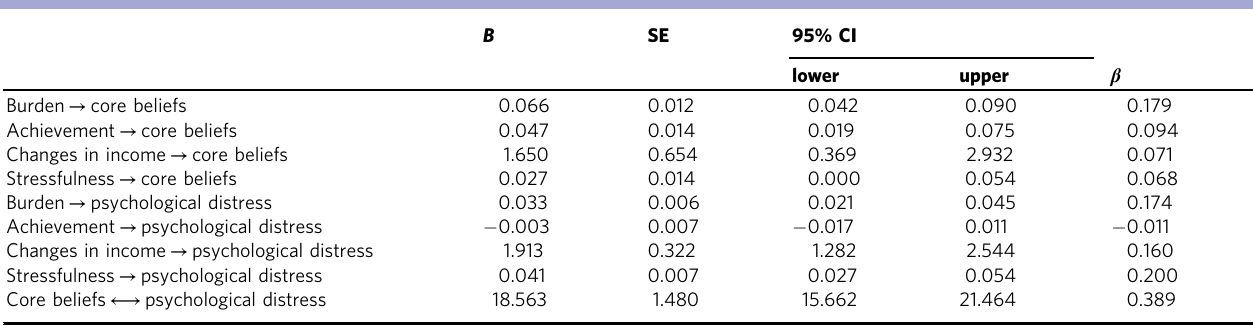
Table 3 Result of the path